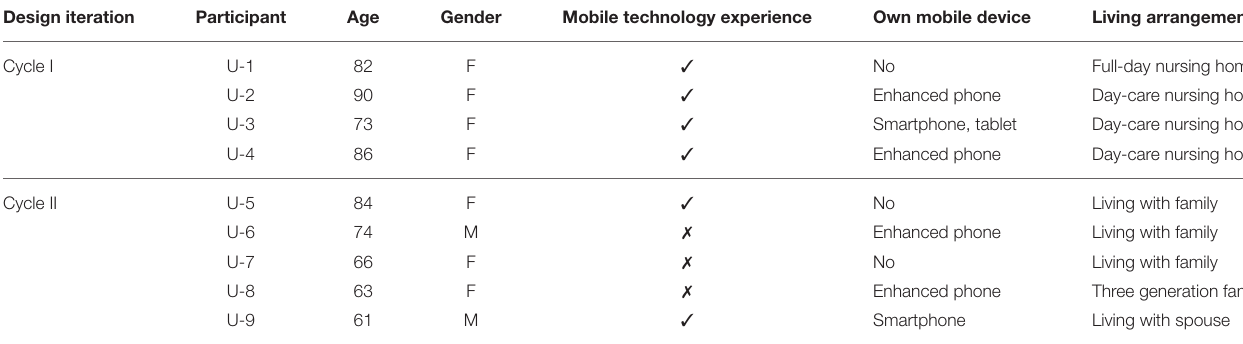
TABLE 1 | Demographics of elderly participants.